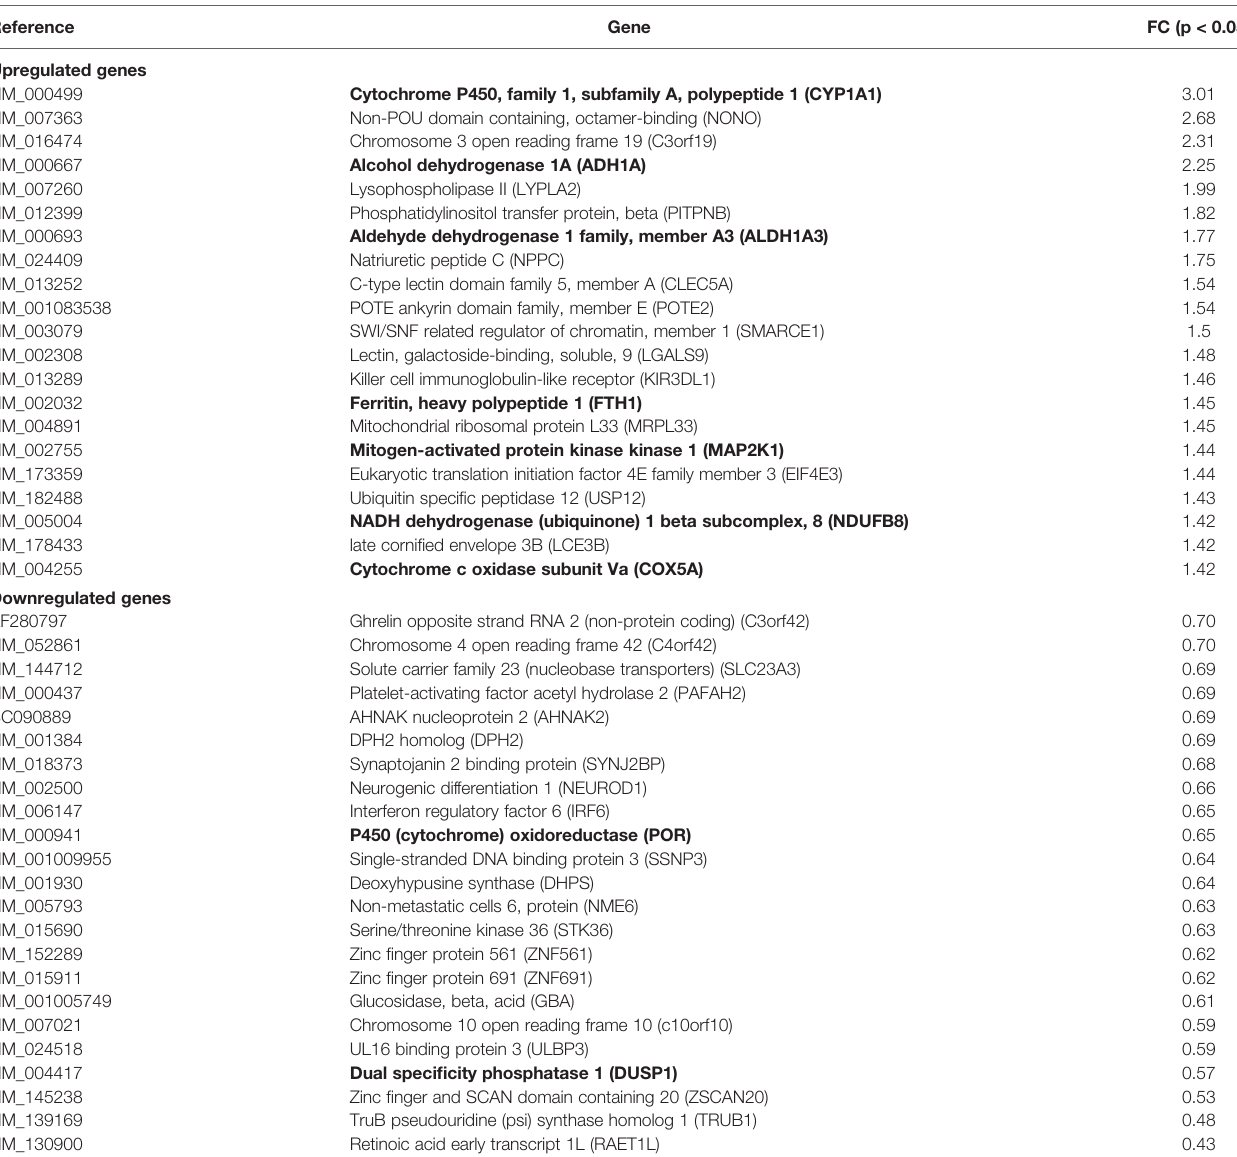
TABLE 1 | Microarray analysis signi fi cantly differentially expressed genes in HT29 CRC cells.